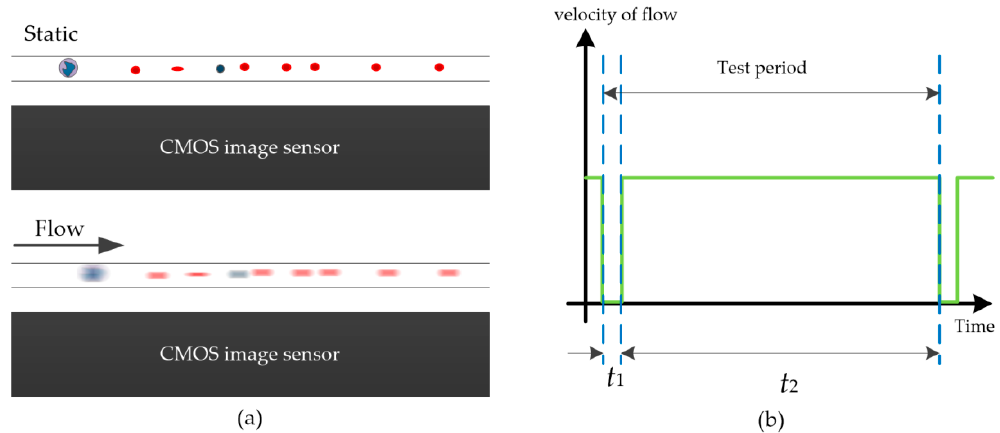
Figure 7. The pulse flow control mode: ( a ) The flow of cells stops in the micro-channel during the CIS exposure time to capture a holographic image of the cells. ( b ) When the system is processing images of cells captured in the last exposure, the tested cells flow out of the micro-channel, and the new cells flow into the micro-channel.